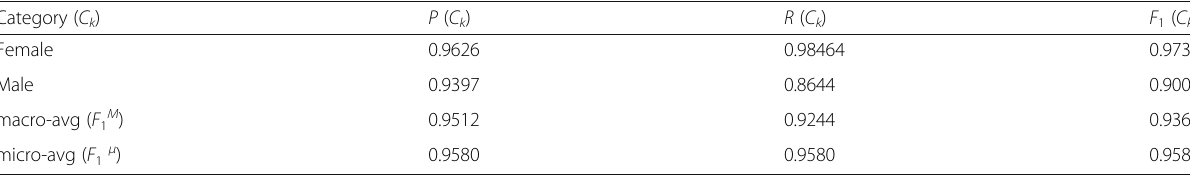
Table 6 Results with norm-binary approach with cross validation = 3